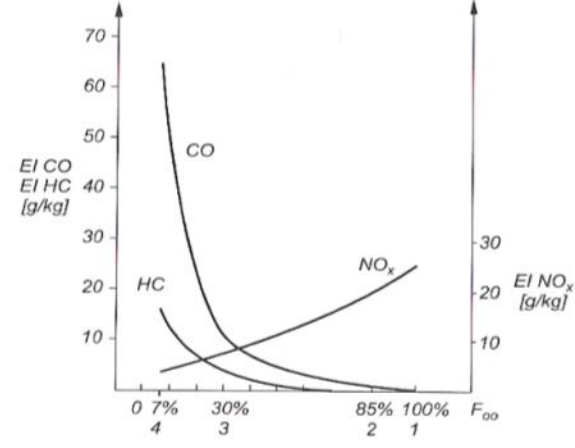
Fig. 7. Approximate course of changes in emission factors: EICO, EIHC, EINO x , as a function of the Thrust